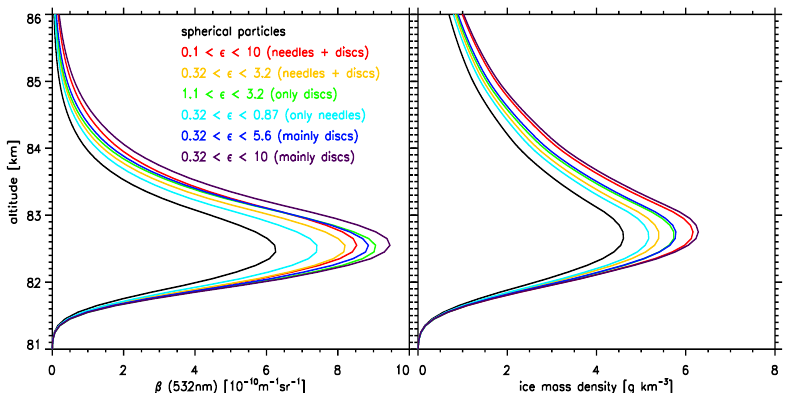
Figure 7. Average NLC parameters north of 60 ◦ N during July of 2009, from the reference simulation (spherical particles) and six sensitivity runs with different distributions of cylindrical particles. Left panel: backscatter coefficient (532nm); right panel: ice mass density (gkm − 3 ). No threshold is used; i.e., zero values are included in the average.